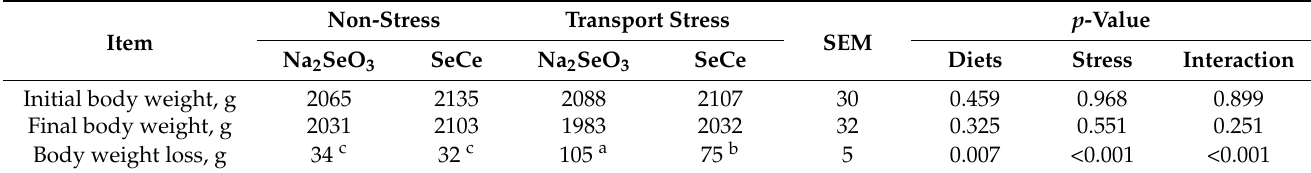
Table 1. Effects of dietary Se-enriched Cardamine enshiensis supplementation on body weight loss of broilers under transport stress 1